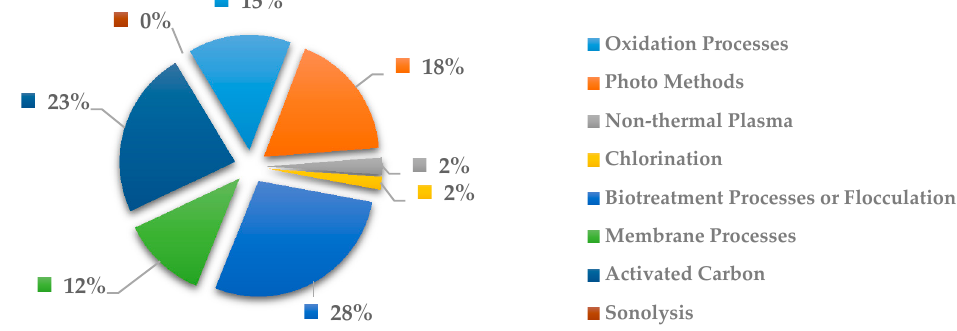
Figure 29. Percentage of scientific articles worldwide regarding wastewater treatments of metabolic disorder drugs between 1998 and 2020. Data collected in Scopus database by using wastewater or water as keywords and English as a language limitation.